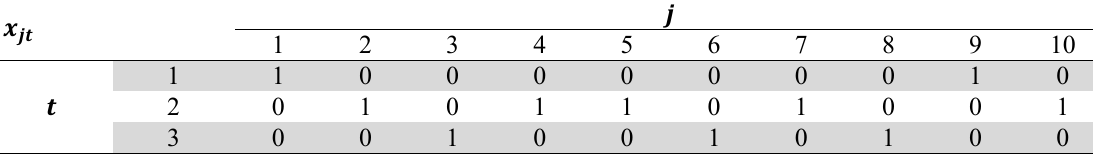
Project (cid:1862) starts at (cid:1872) (cid:2206) (cid:2192)(cid:2202)